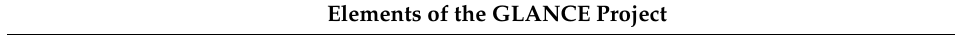
Table 1. Elements of the GLANCE (GLanceable Alarm Notification for a User Centered Experience)